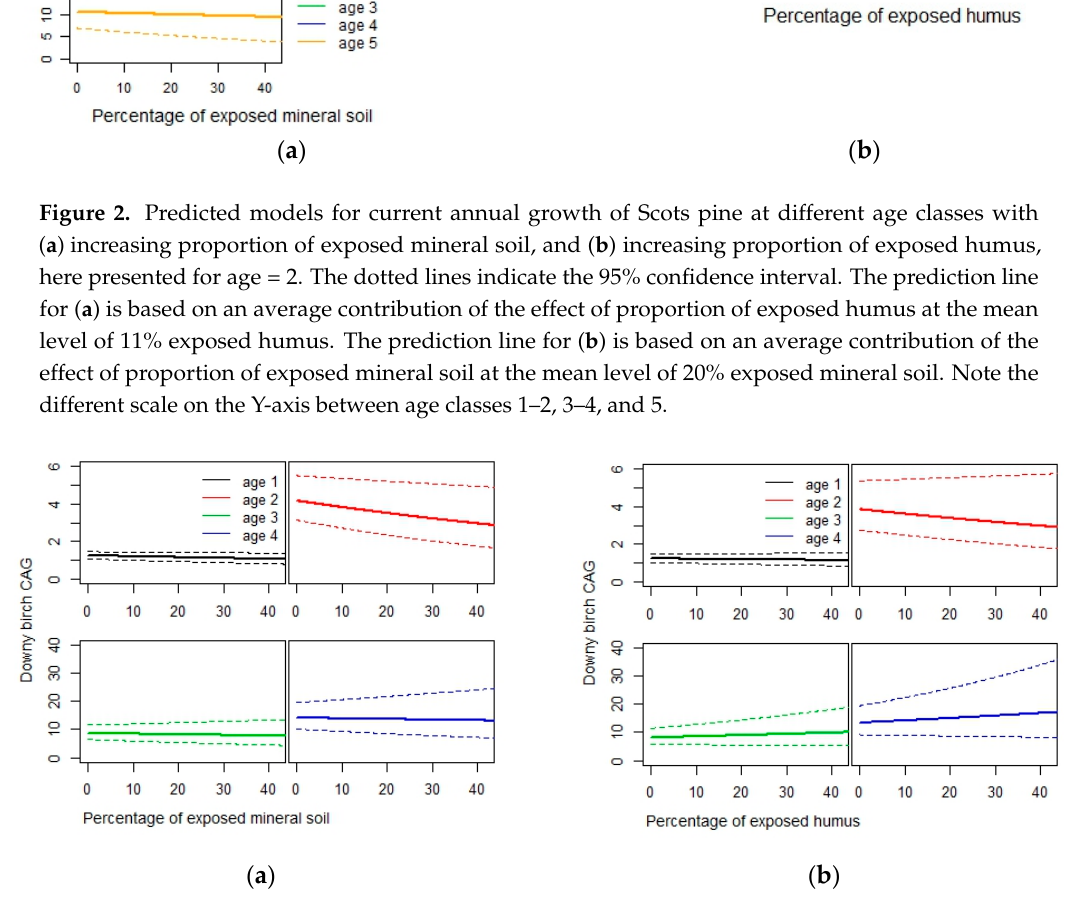
Figure 3. Predicted model for current annual growth of downy birch top shoots at different age classes with ( a ) increasing proportion of exposed mineral soil, and ( b ) increasing proportion of exposed humus.